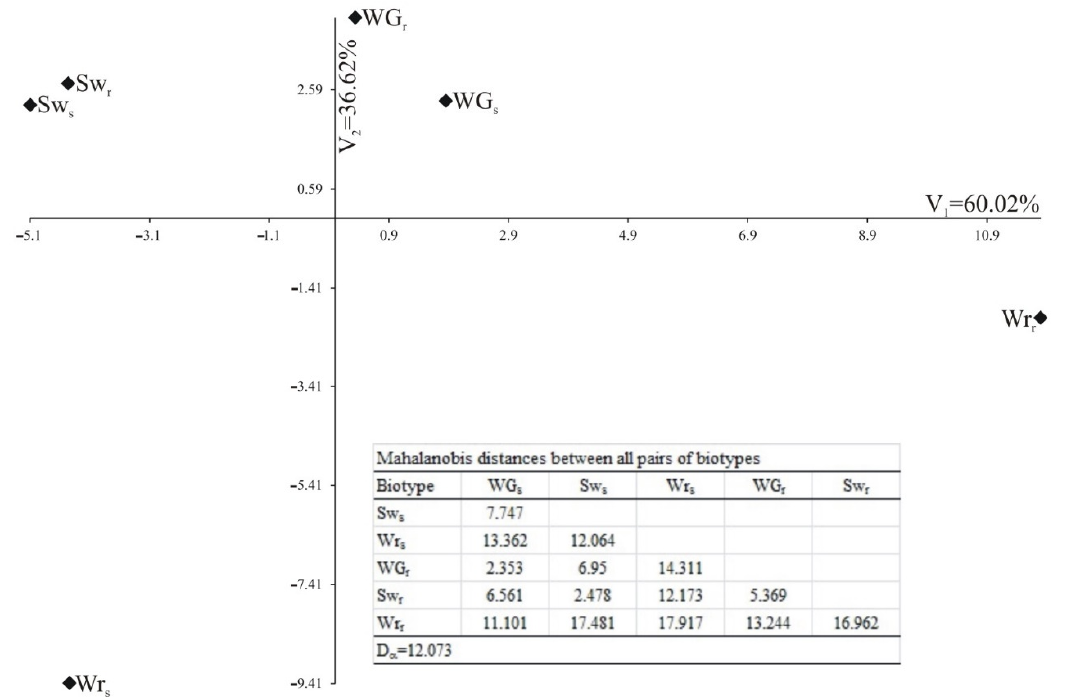
Figure 6. Distribution of combinations of sites and herbicide-resistance (R)/susceptibility (S), based on parameters of winter wheat (WW), in the space of the first two canonical variables (V 1 and V 2 ), in 2017–2018. Sites: Sw– Swojczyce, WG–Winna Góra, Wr–Wroc ł aw. Subscript “r” denotes the competition of WW with R and the subscript “s” with S.